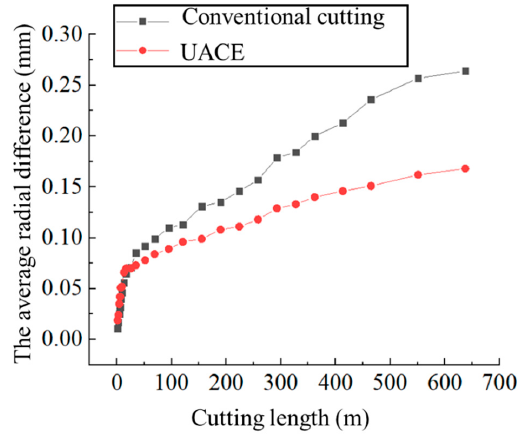
Figure 8. The radial difference of the disc cutter: ( a ) Position 1; ( b ) Position 2; ( c ) Position 3; ( d ) Position 4.